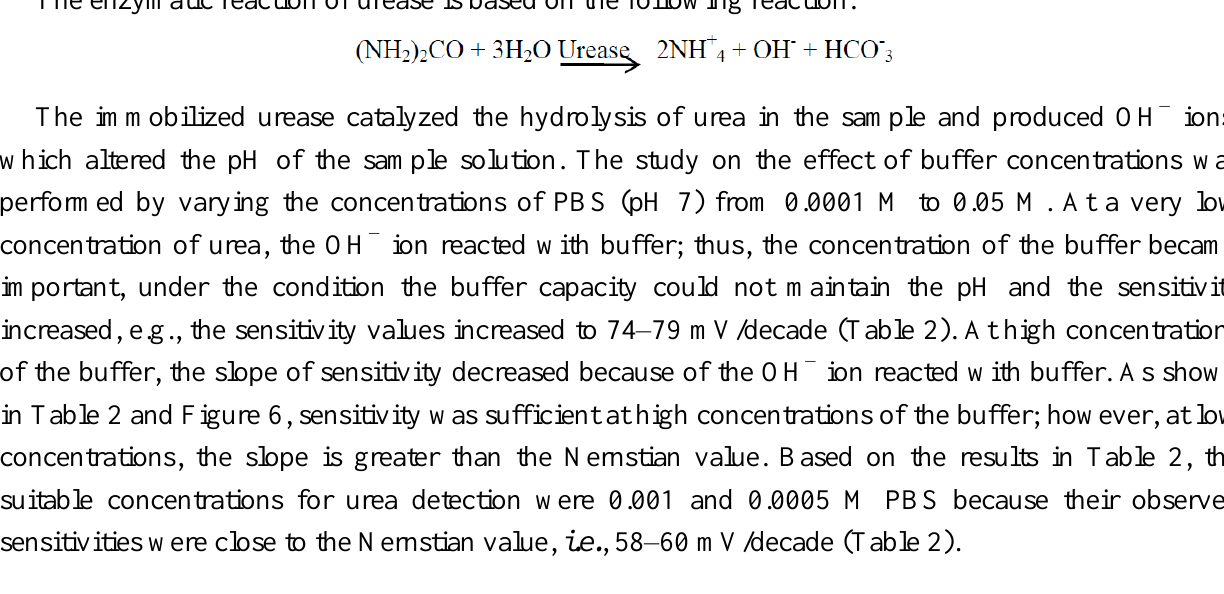
Table 1. Effect of DCC or EDC on the response of the C